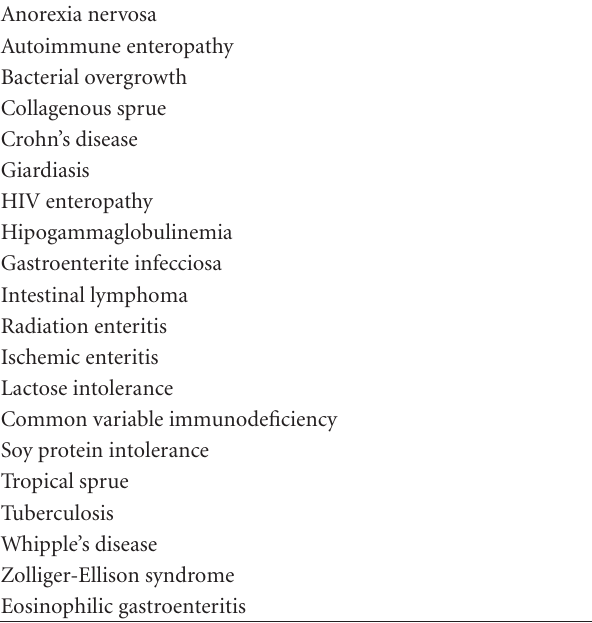
Table 5: Celiac disease di ff erential diagnosis [12].